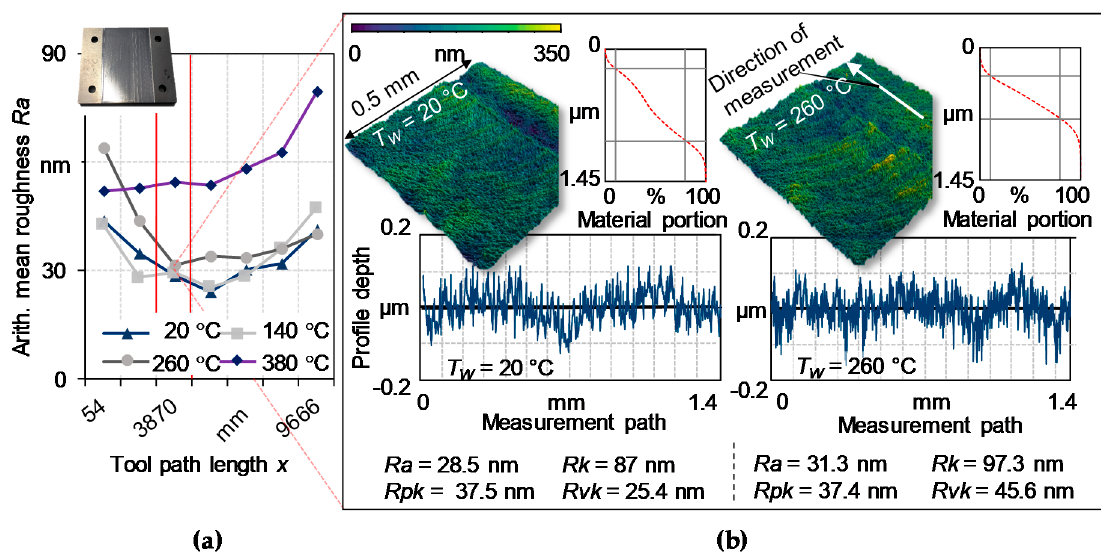
Figure 4. ( a ) Determined surface roughness Ra over cuttings distance under varying workpiece temperatures T W ; ( b ) resulting topography after a tool path length of x = 3870 mm.